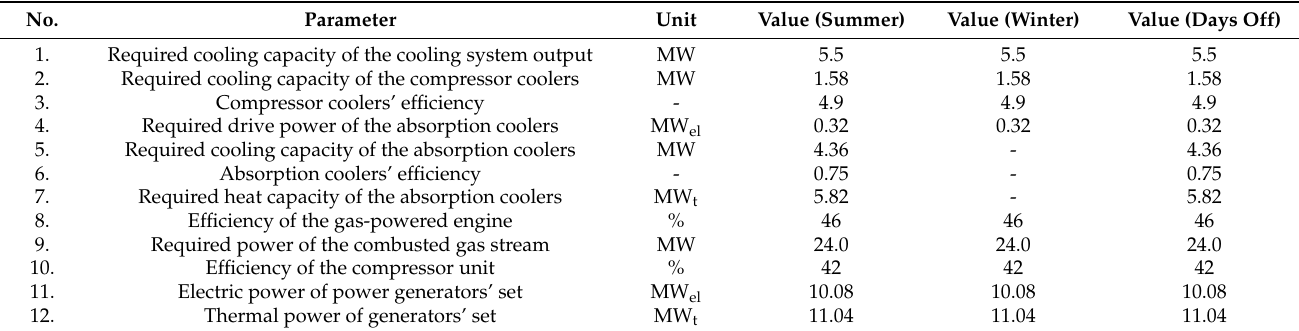
Table 6. Cooling capacity balance of the central air-conditioning